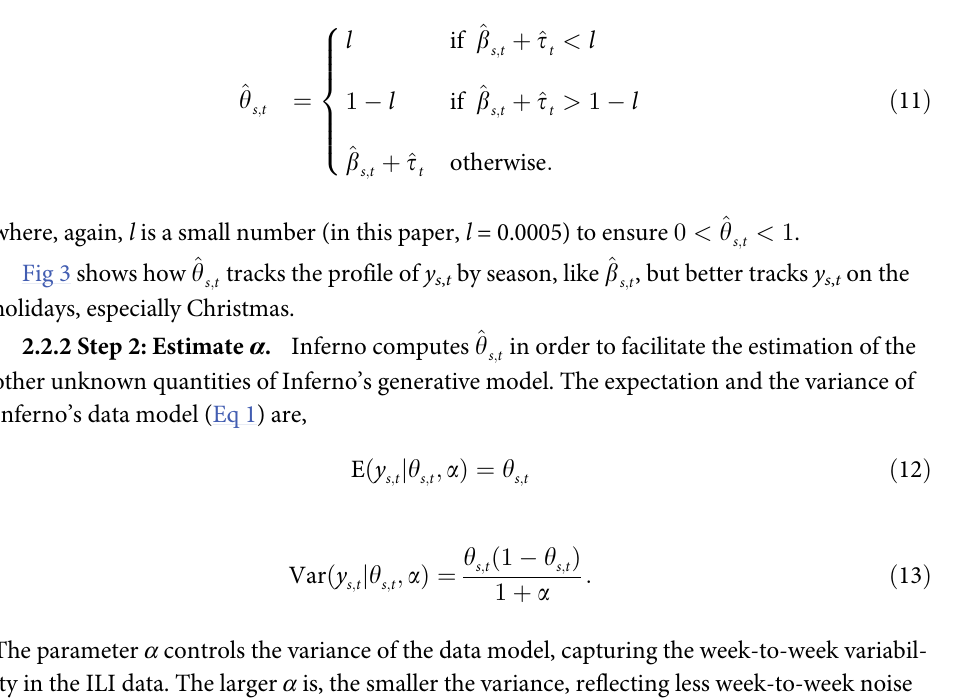
Fig 2. Each boxplot summarizes the quantity ^ t systematically positive, likely as a result of systematic changes to reporting and care-seeking behavior over the